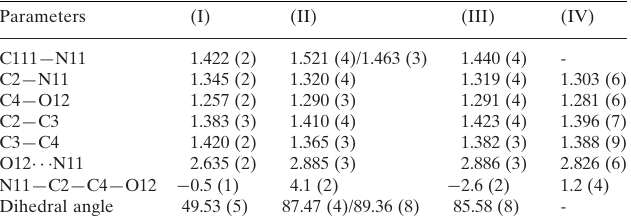
Comparative geometrical parameters (A˚ , (cid:3) ) for free and coordinated N , O -bidendate ( N , O -bid) compounds.